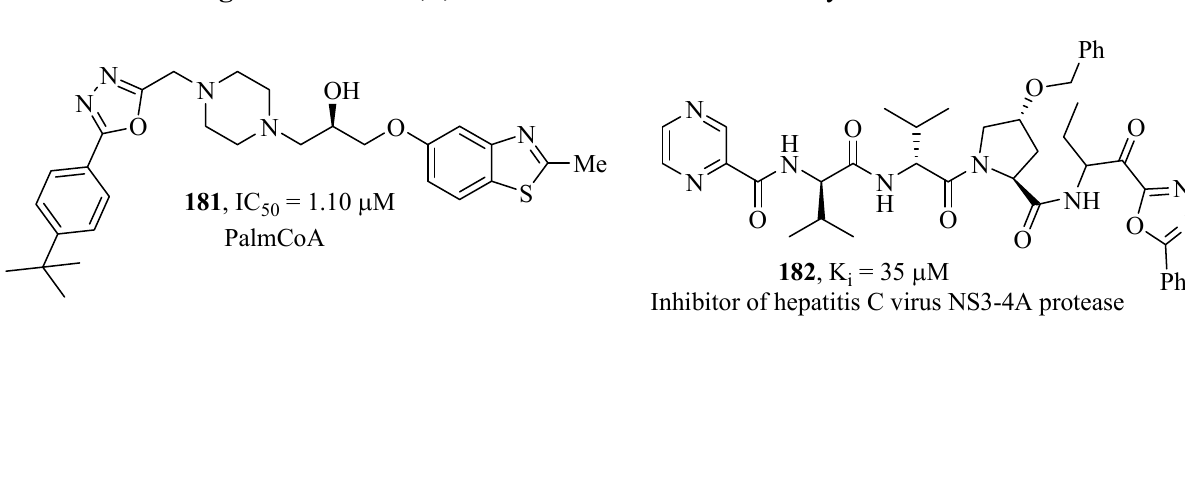
Figure 17. Other 1,3,4-oxadiazole derivatives as enzymes